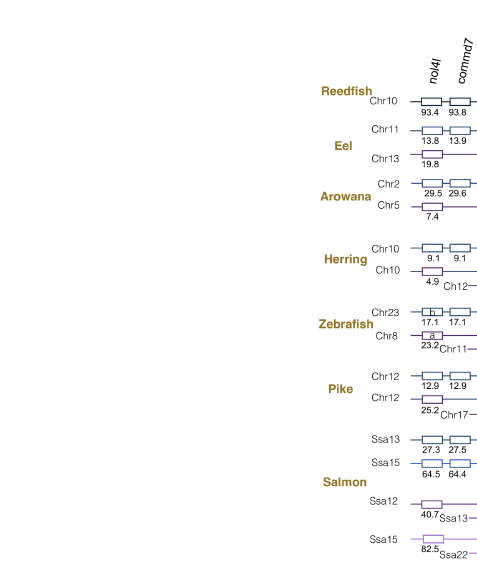
FIGURE 3 | Synteny of crh2 genomic region in actinopterygians. Crh2 gene neighborhood is compared between teleost representatives, eel, arowana, herring, zebra fi sh, pike and salmon. The polypteriform actinopterygian, reed fi sh, was used as model of the gene arrangement prior the teleost genome duplication 3R. Chromosomes are indicated by Chr or Ssa for salmon. Gene position are indicated under the genes. Loss of crh2 gene is indicated with a red cross. Neighboring genes non-represented are considered as lost. Gene references are presented in Table S3 . Letters a and b indicate the 3R-teleost duplicated paralogs and the symbols a and b the 4R-salmonid duplicated paralogs. Members of gene families conserved on the vertebrate tetraparalogon (issued from 1R/2R WGD) are with the same color in Figures 3 , 4